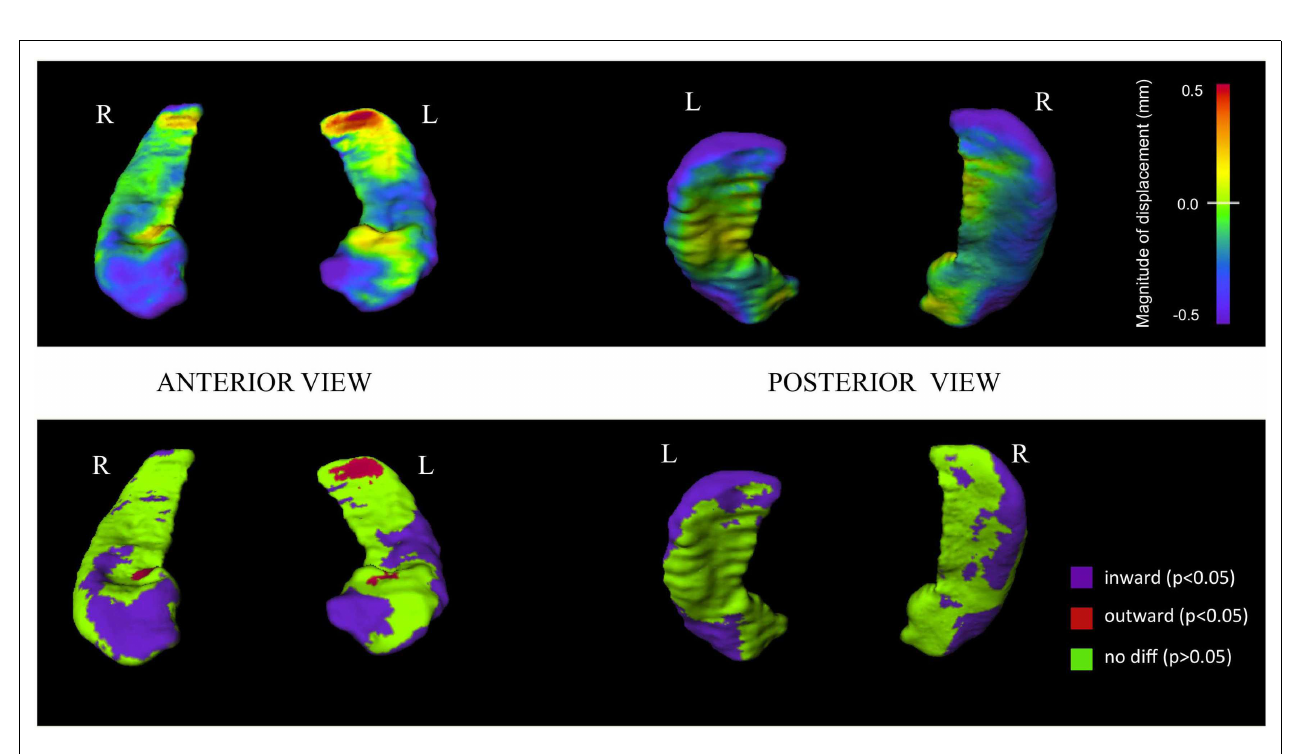
Red/orange shading denotes regions of outward displacement (i.e., surface expansion). Bottom row: structural differences shown using a color-coded scale thresholded at statistical significance. Purple regions show statistically significant ( p < 0.05) inward displacement in psychotic patients compared to controls. Red regions show statistically significant ( p < 0.05) outward displacement in psychotic patients compared to controls. Green regions indicate statistically similar group values. Surface vertex differences are thresholded at a false discovery rate (FDR) of 5% (i.e., q = 0.05) applied to Mann–Whitney U test based p